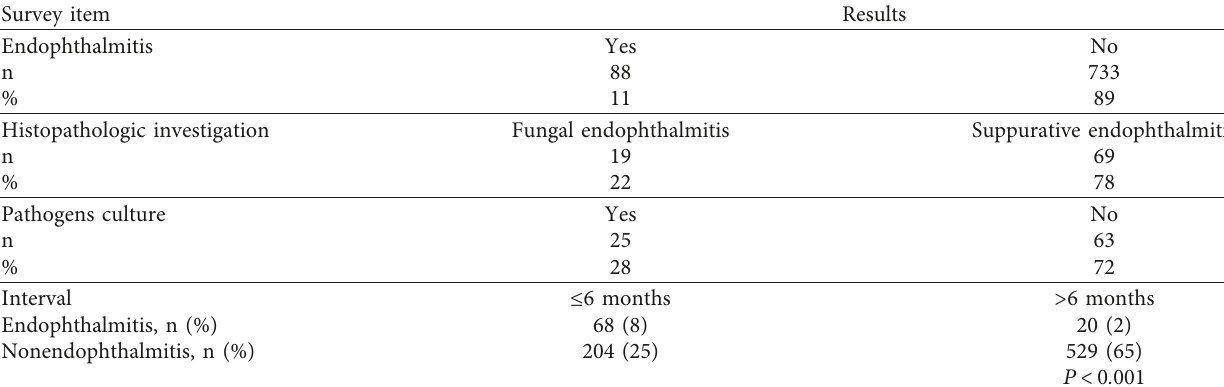
Table 2: Analysis of the relationship between endophthalmitis and evisceration.